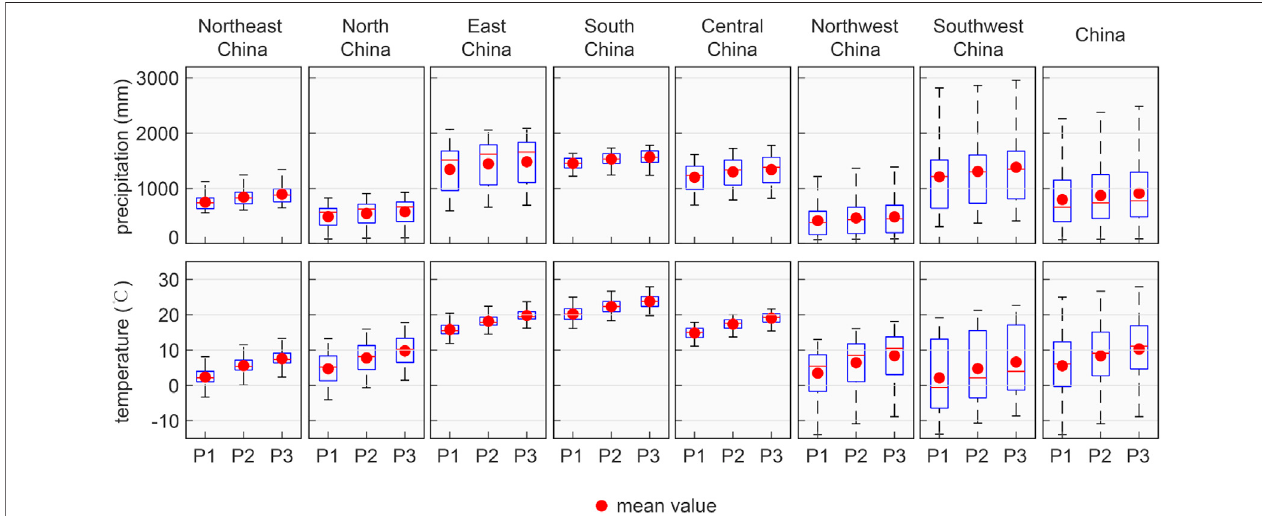
FIGURE 5 | Changes in annual precipitation and the annual mean temperature in China and its seven regions in the historical and future periods. Among them, P1 represents 1965 – 2014, P2 is 2051 – 2100 under SSP245, and P3 is 2051 – 2100 under SSP585.